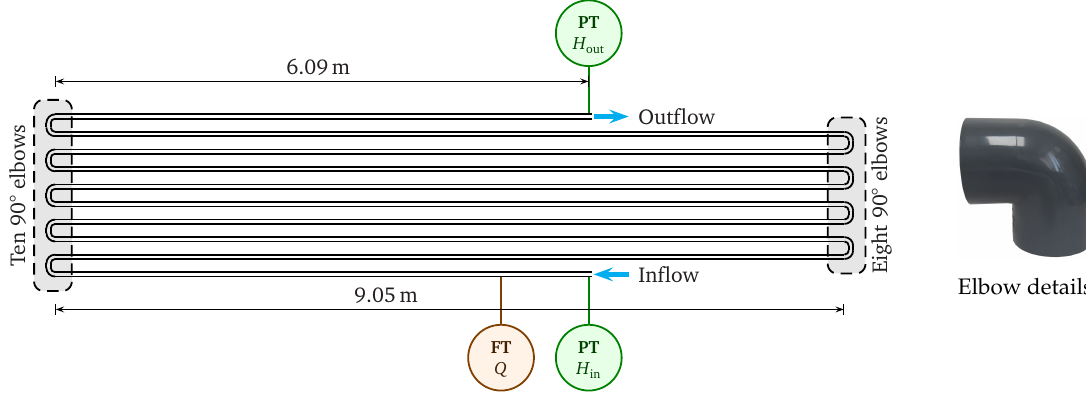
Figure 4. Top view of the prototype